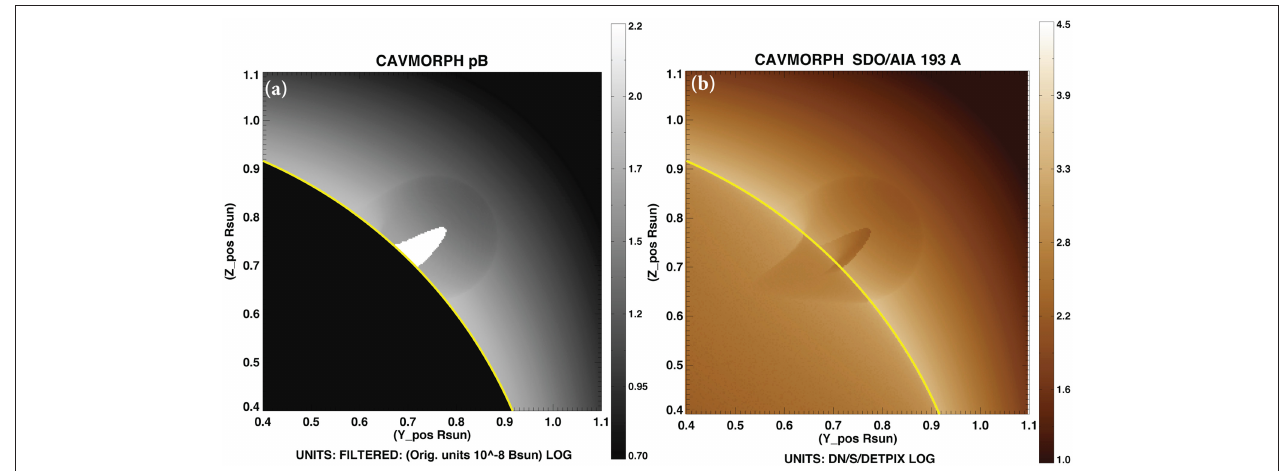
FIGURE 5 | A simplified cavity and prominence produced using the Gibson et al. (2010) model. (A) synthesized white light polarized brightness (see Section 3.1), with high-density prominence appearing as enhanced intensity. Plot obtained by FORWARD line command: for_drive,'cavmorph', /nougat,thcs=45,cdens=1e10,cff_noug=[.2,8.,0,0,0,0],nougwidth=.025,nougtop_r=.9,pop2T=2,xxmin=0.4,yymin=0.4,yymax=1.1, xxmax=1.1 . (B) SDO/AIA 193 Å emission, with dark prominence because of continuum absorption (see Sections 3.2–3.3). Plot obtained by above command with the addition of keyword /aia